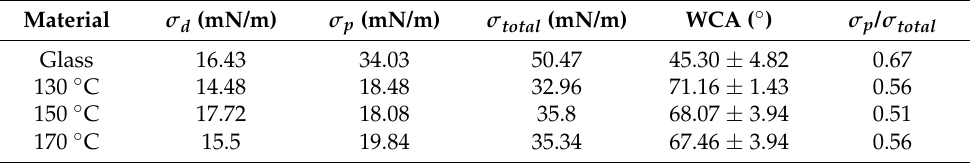
Table 1. Surface energy components and water contact angles (WCAs) of glass and PGS samples cured at different temperatures, calculated from contact angle data, and using the OWRK